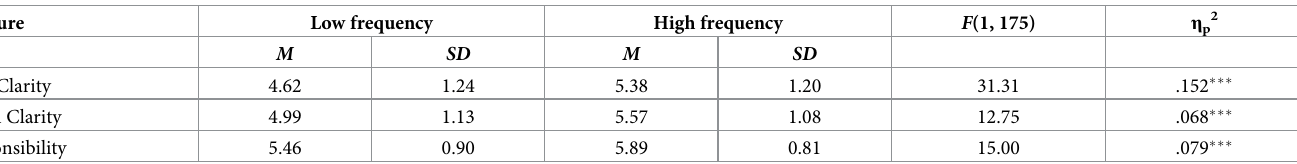
Table 6. Results of all three ANCOVAs in Study 3 ( N =